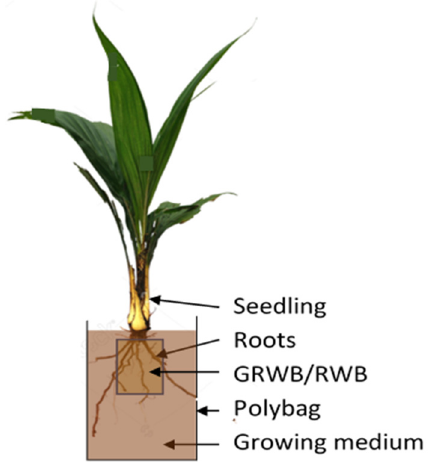
Figure 1. Sitting technique: positioning the seedling on the Ganoderma rubber wood block (GRWB)/Rubber wood block (RWB) during transplantation into a polybag.